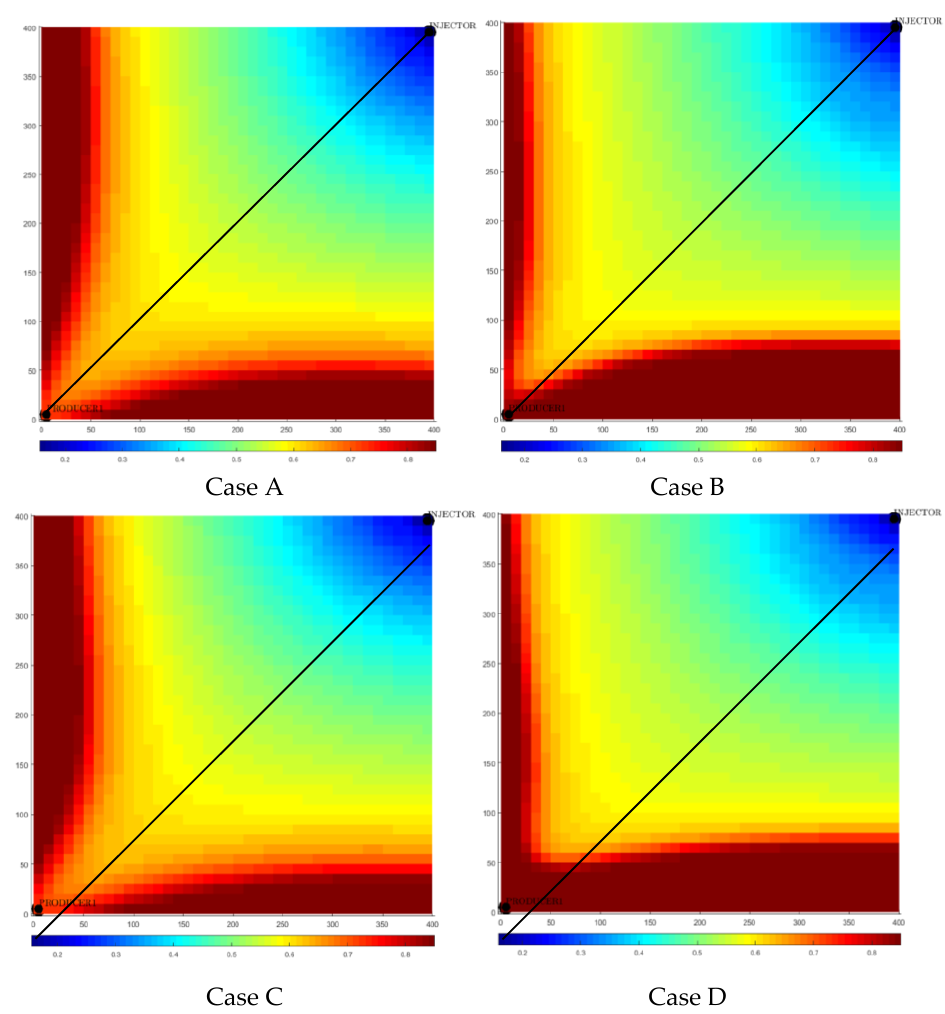
Figure 5. The remaining oil saturation distribution of the four cases at the 50th time